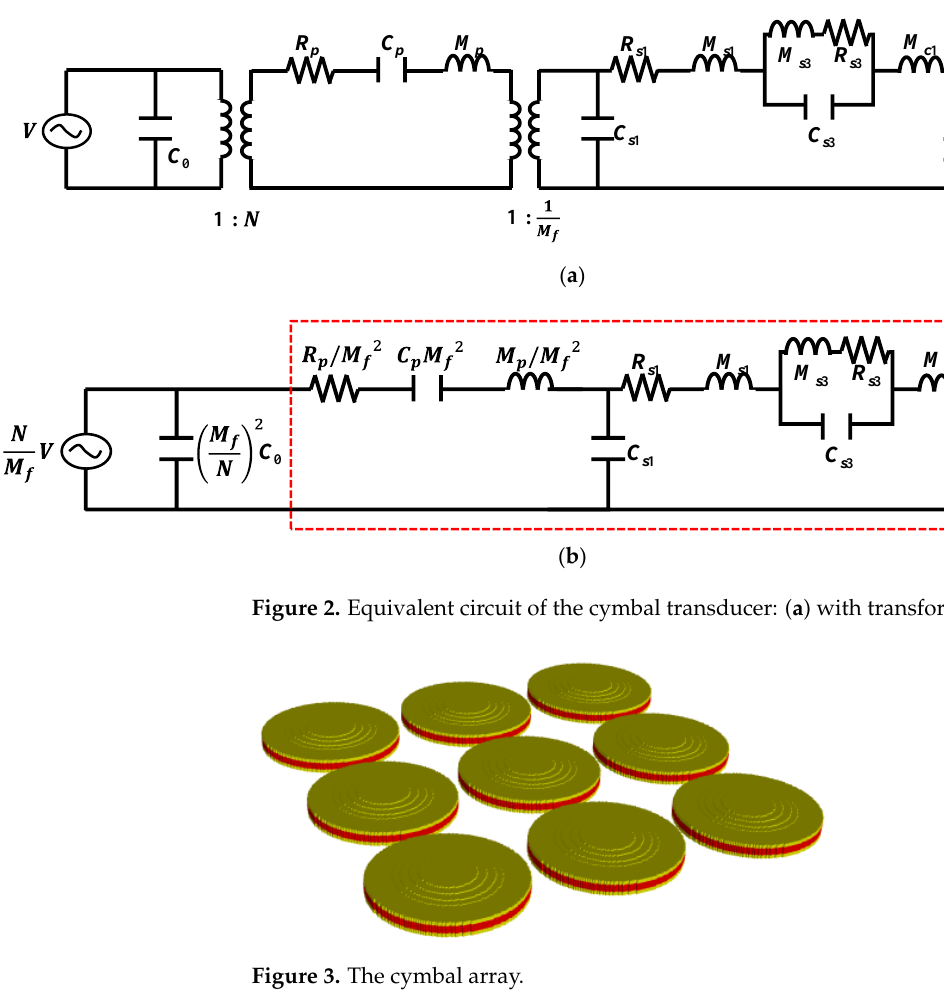
Figure 4. Equivalent circuit of the cymbal array. In Figure 4, the subscript T is the total number of cymbals in the array, while 𝑉 𝑖 , 𝑁 𝑖 , 𝑀 𝑓𝑖 , 𝐶 0𝑖 , 𝑍 𝑚𝑖 , and 𝑈 𝑖 are the input voltage, piezoelectric turns ratio, amplification factor of the cap, clamped capacitance of the piezoceramic disk, mechanical impedance, and vol- umetric velocity of the i th cymbal, respectively. [𝑍 𝑎 ] is the acoustical impedance network matrix composed of the self-radiation impedance of the cymbals constituting the array and mutual radiation impedance between the cymbals [16]. Unlike previous studies, a new form of the acoustic impedance network was developed in this study to incorporate the exact mutual radiation impedance for a more accurate analysis of the acoustic charac- teristics of the cymbal array. 2.1. Mutual Radiation Impedance Figure 5 shows two single-mode piston sources, 𝑖 and 𝑗, with radii, 𝑎 and 𝑏 , re- spectively, and are separated by a distance, 𝑑 𝑖𝑗 . The mutual radiation impedance, 𝑍 𝑖𝑗 , be- tween two sound sources, is frequently calculated using Equation (1) [25]: Figure 5. Arrangement of two piston sources. 𝑍 𝑖𝑗 = 2𝜌 𝑟 𝑐 𝑟 𝜋𝑎 2 ∑ 1 √𝜋 𝛤 (𝑠 + 1 2) ∞ 𝑠=0